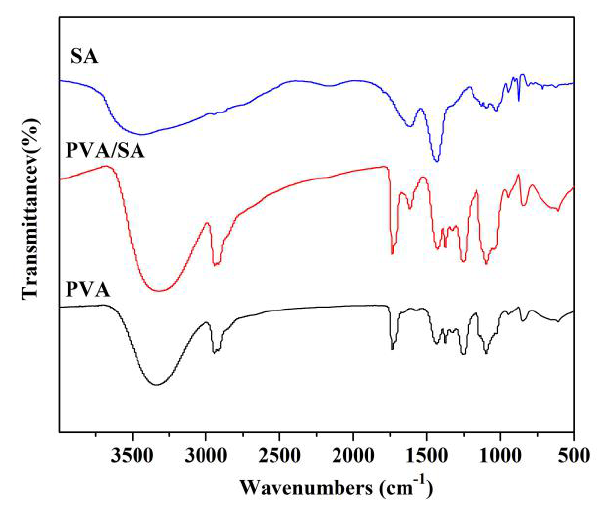
Figure 3. FTIR spectra of samples.